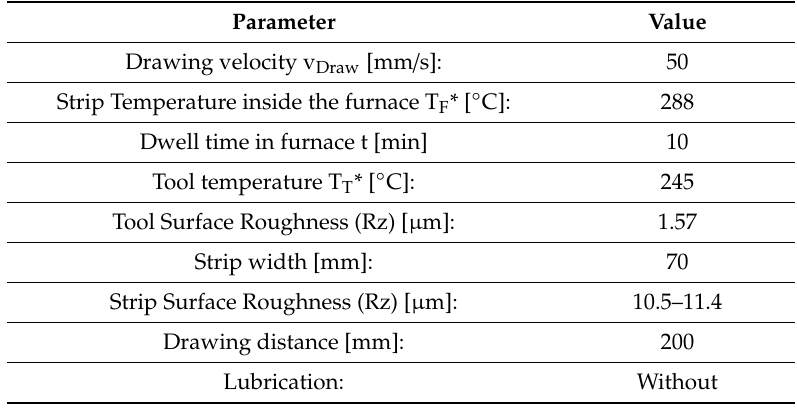
Table 2. Strip Drawing Test Parameters.